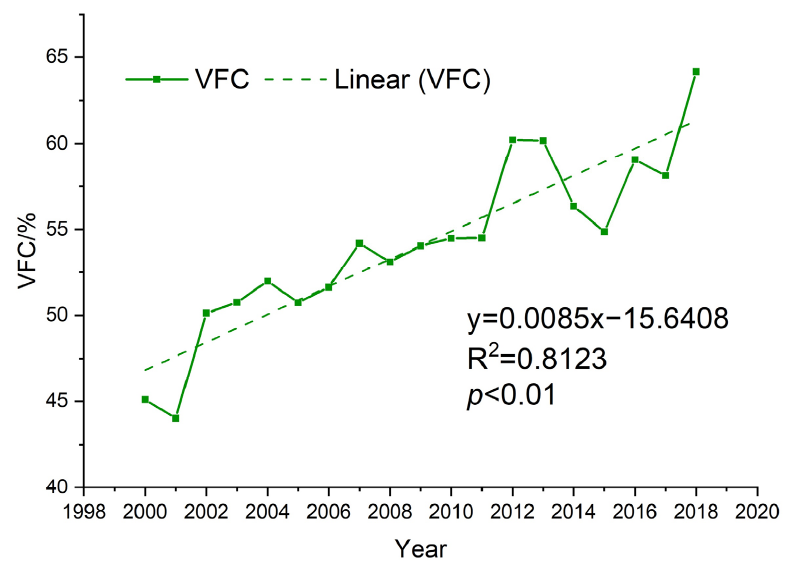
Figure 5. Temporal trends of VFC in the Loess Plateau from 2000 to2018.